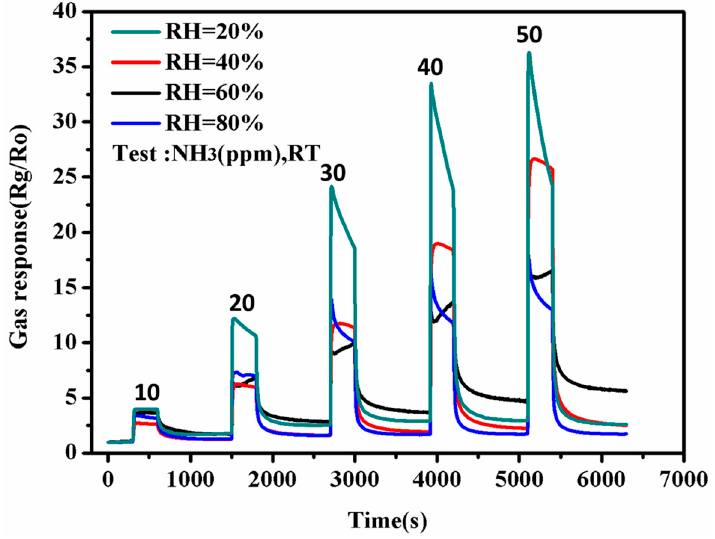
Figure 12. The influence of relative humidity on the performances of nanotubes sensor to ammonia from 10 to 50 ppm at room temperature (between 20% and 80% of relative humidity (RH)).